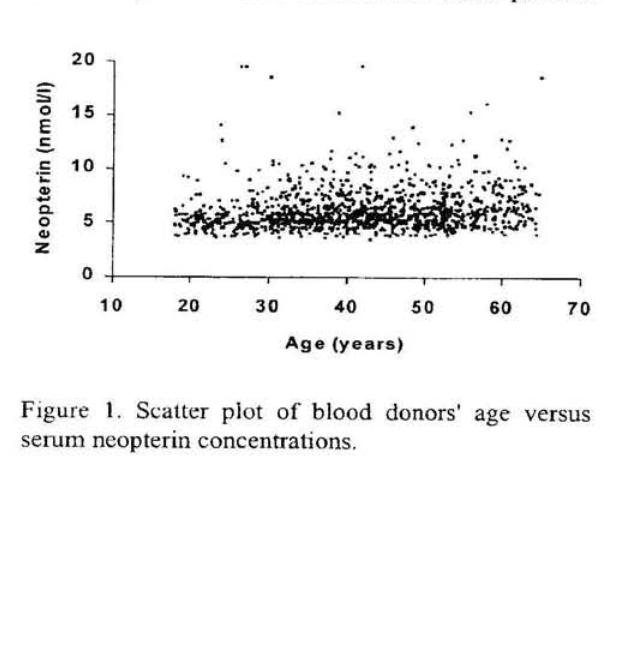
Figure 1. Scatter plot of blood donors' age versus serum neopterin concentrations.